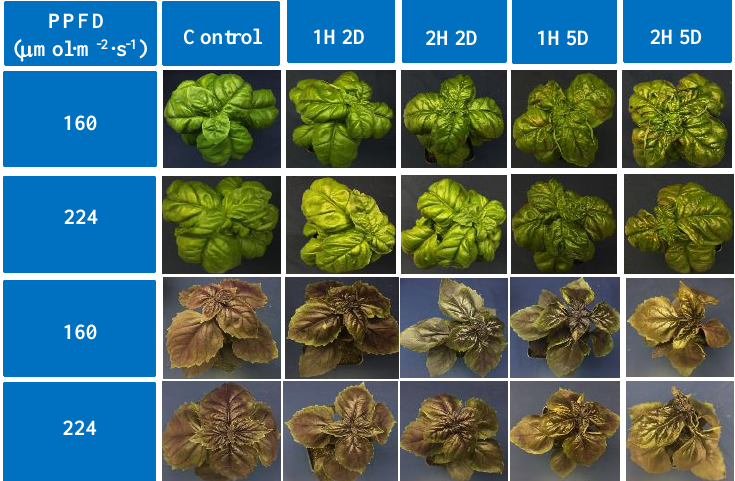
Figure 3. Green basil ‘Improved Genovese Compact’ and purple basil ‘Red Rubin’ plants under different treatments at harvest. There were 10 treatments created by the combination of two photosynthetic photon flux density (PPFD) levels of 160 and 224 μ mol·m − 2 ·s − 1 and five UV-B radiation treatments including control, 1H2D, 2H2D, 1H5D, 2H5D. Shoot FW and DW of green and purple basil plants were generally lower in plants grown under supplemental UV-B treatments, and interactive effects (UV-B × PPFD) were observed on shoot FW ( p = 0.01) and shoot DW ( p = 0.02) in purple basil plants, while only interactions in shoot DW were observed in green basil plants ( p = 0.03). Specifically, under low PPFD (160 μ mol·m − 2 ·s − 1 ), treatment 1H2D showed no effects on shoot FW in green basil plants. So did the 1H2D and 1H5D treatments in purple basil plants, while under high PPFD (224 μ mol·m − 2 ·s − 1 ), shoot FW in both cultivars was lower under UV-B treatments compared to control (Figure 4A,B). Figure 4. Shoot fresh weight and shoot dry weight of green basil ‘ Improved Genovese Compact ’ plants ( A ), and purple basil ‘Red Rubin’ plants ( B ) under different treatments. There were 10 treatments created by the combination of two photosynthetic photon flux density (PPFD) of 160 and 224 μ mol·m − 2 ·s − 1 and five UV-B radiation treatments including control, 1H2D, 2H2D, 1H5D, 2H5D.